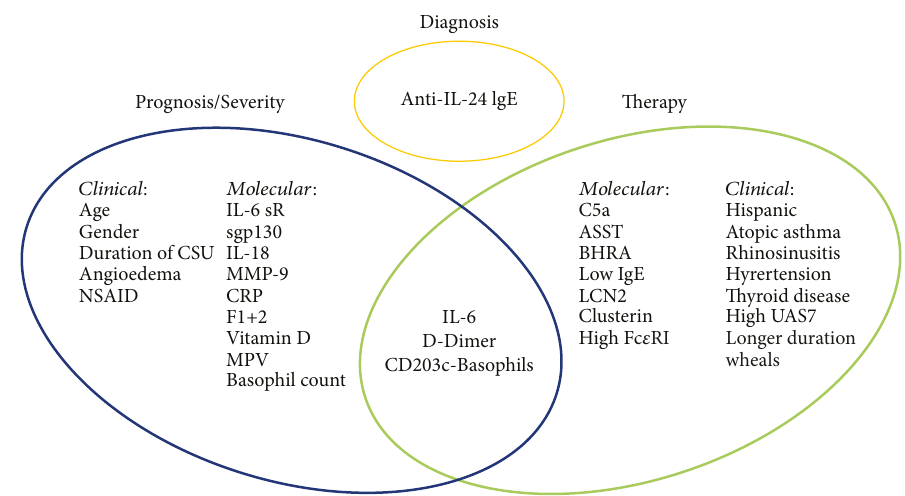
Figure 1: Clinical and molecular biomarkers in CSU. Table 1: Biomarkers of diagnosis, prognosis, and